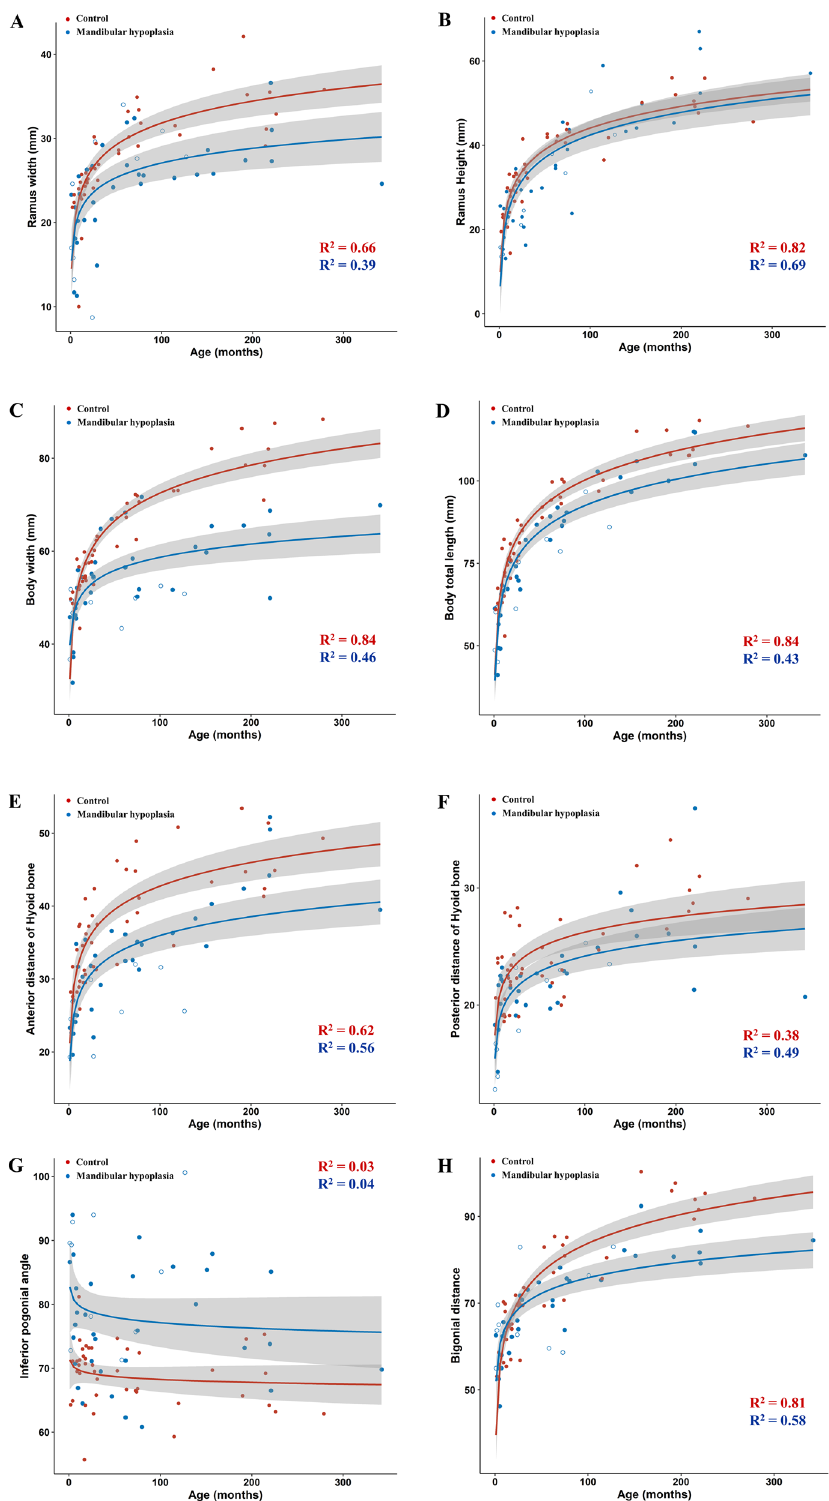
Figure 2. Developmental differences in ramus width and height ( A , B ), body width and the total length of the mandible ( C , D ), anterior and posterior distance of hyoid bone ( E , F ), inferior pogonial angle, and bigonial distance ( G , H ) according to age between the mandibular hypoplasia and the control groups. The red line indicates the developmental curve of the healthy controls. The blue line indicates the developmental curve of the patients with mandibular hypoplasia. The grey zone indicates a 95% confidence interval. The open circle represents patients with a difficult airway among those with mandibular